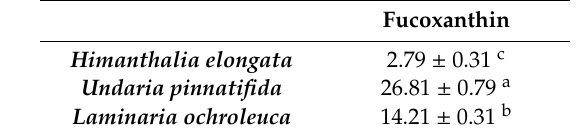
Table 3. Fucoxanthin content of brown edible algae ( Himanthalia elongata , Laminaria ochroleuca (Kombu), Undaria pinnatifida (Wakame)) extracted using DMSO-water (4:1, v / v ) as solvent. The results are expressed in µ g / g of